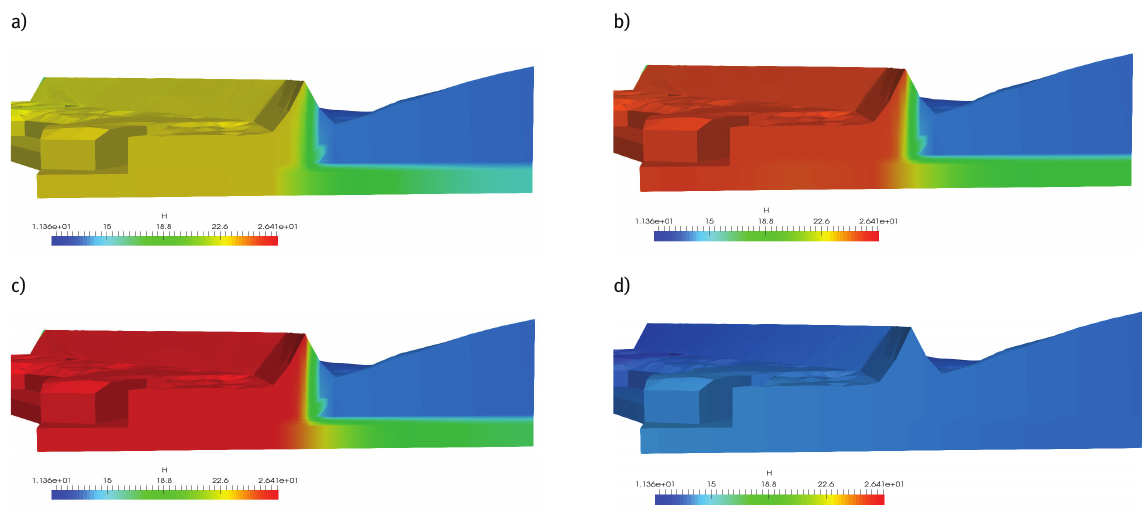
Figure 8: Isolines of hydraulic head in a selected cross-section relative to the elevation of 170 m above sea level after: b) 1 day, b) 2.5